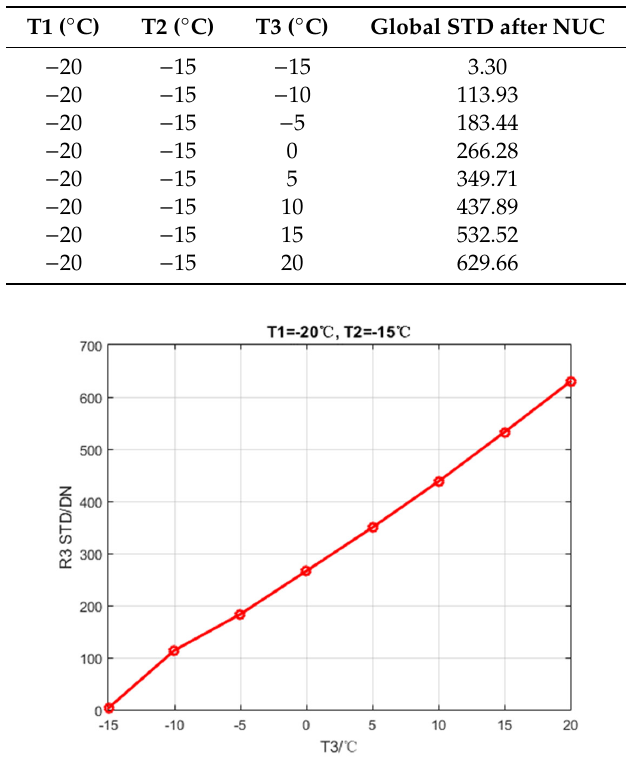
Figure 6. Global STD after NUC changes with T3.